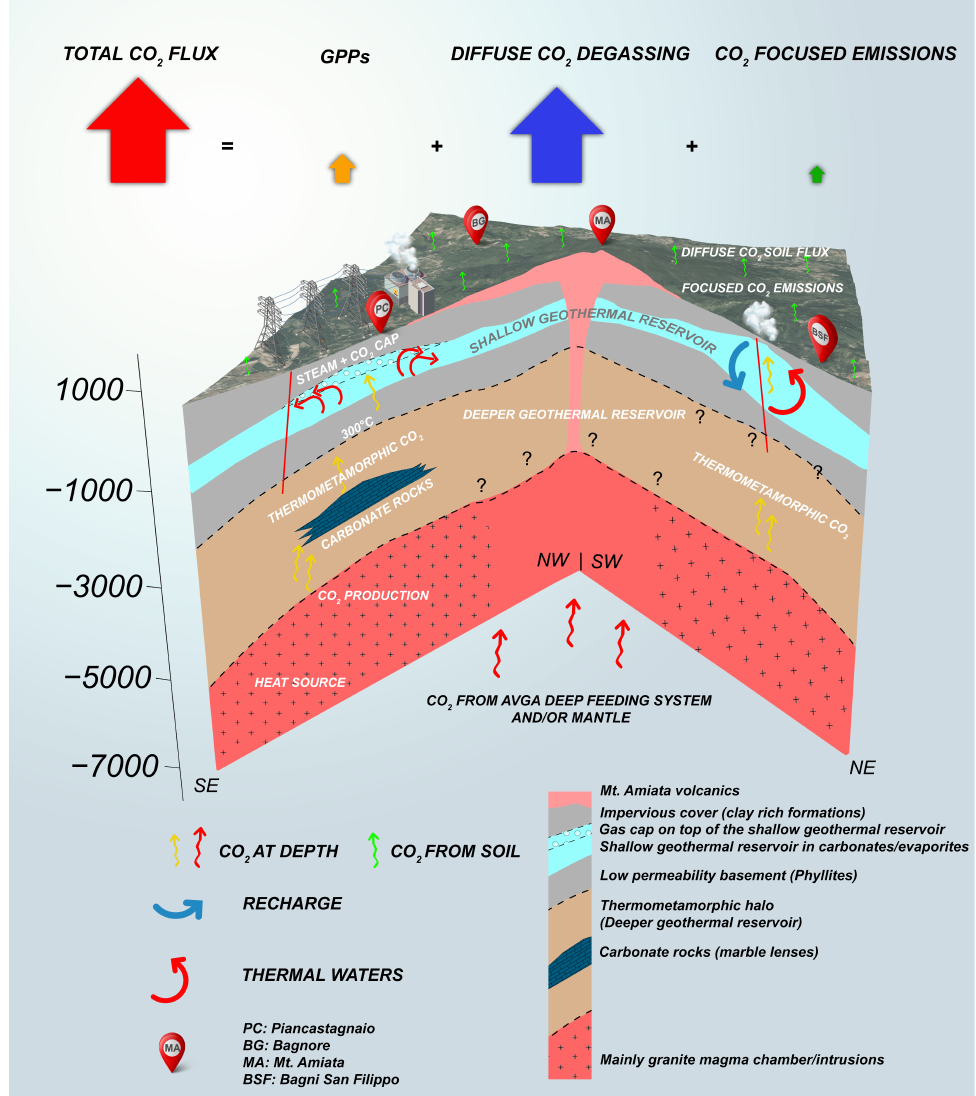
Figure 11. Conceptual model exemplified in a section crossing the Piancastagnaio geothermal field and the undisturbed Bagni San Filippo area (Icons designed by